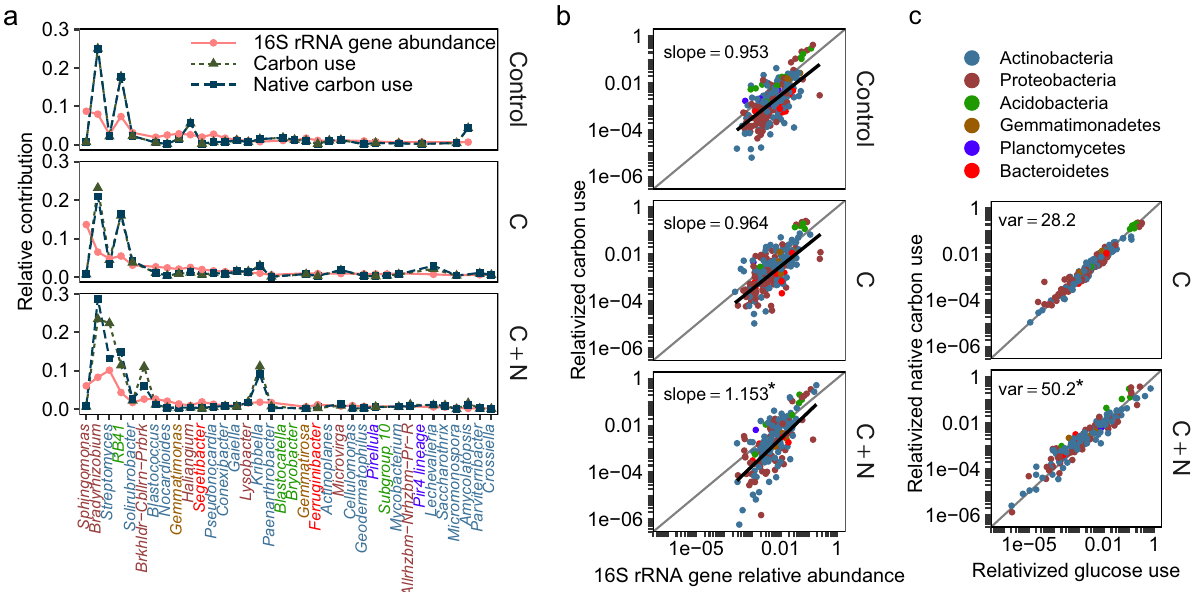
Fig. 4 Comparison of relative abundance and relativized carbon (C) use of soil bacterial genera. Points show relative contributions from individual bacterial genera. Values are averages across soil replicates from four ecosystems (mixed conifer forest, ponderosa pine forest, piñon pine-juniper scrubland, and desert grassland) and amended with either water (Control, labeled with 18 O), glucose (C), or glucose and [NH 4 ] 2 SO 4 (C + N) ( n = 3 experimental replicates). a Comparison of the relative abundance and relativized C use of the top 36 most abundance genera. Colors correspond to bacterial phyla (six phyla accounted for >99% of C fl ux). Symbols correspond to the metric being compared for each taxon (relative abundance of 16S rRNA gene amplicon sequences, relativized use of soil C, or relativized use of native soil C excluding added glucose). b Comparison of relative abundance and relativized C use across all genera. Trend lines show best fi t from a linear mixed model accounting for differences between ecosystems and bacterial genera. Asterisks represent signi fi cant differences of slopes from the 1:1 line (two-sided unadjusted t -tests; C:Control t 287 = − 0.60 ± 0.06 (std error), p = 0.548, effect-size r = − 0.0007; C + N:Control t 489 = 2.42 ± 0.06, p = 0.016, effect-size r = 0.012). c Comparison of relativized glucose use and relativized native soil carbon use across all genera, with variance (var) around trend lines included. Asterisks represent signi fi cant differences in variance in C + N soils compared to C soils ( F 22,770 = 3.53, p < 0.001, Cohen ’ s d =